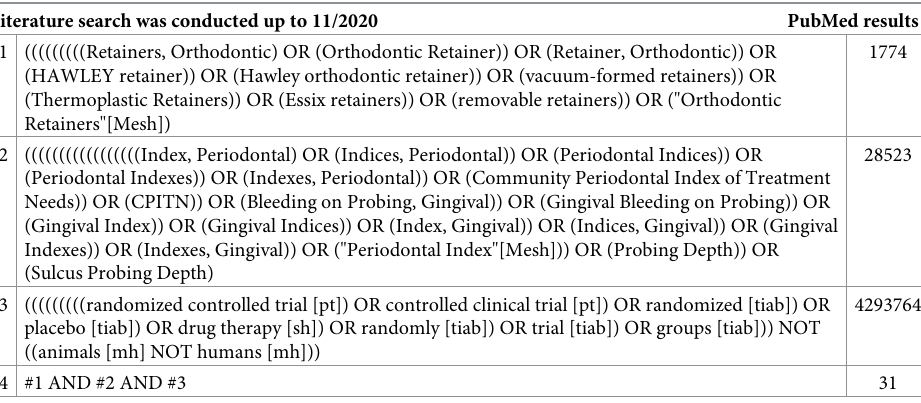
Table 1. Search strategy for